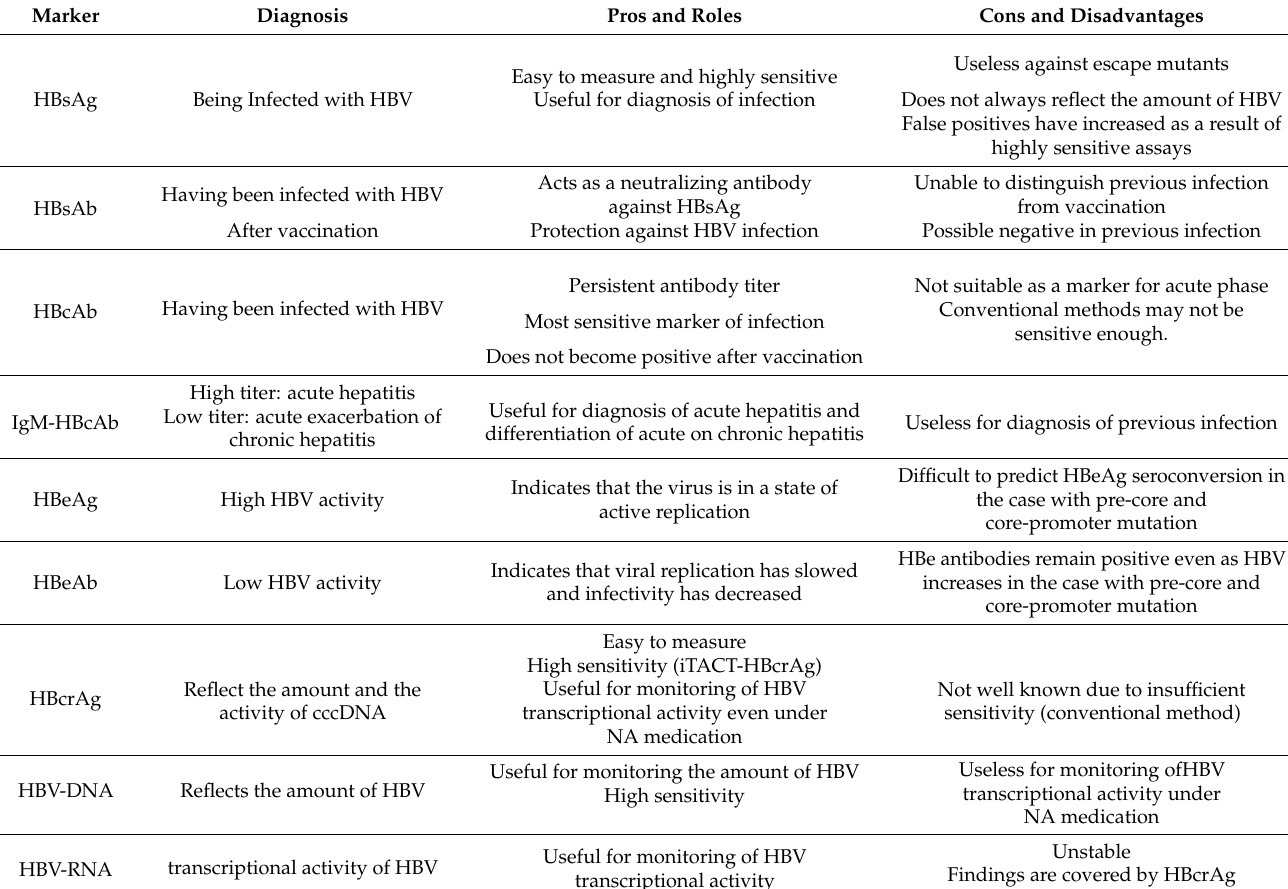
Table 2. The Pros and Cons of HBV